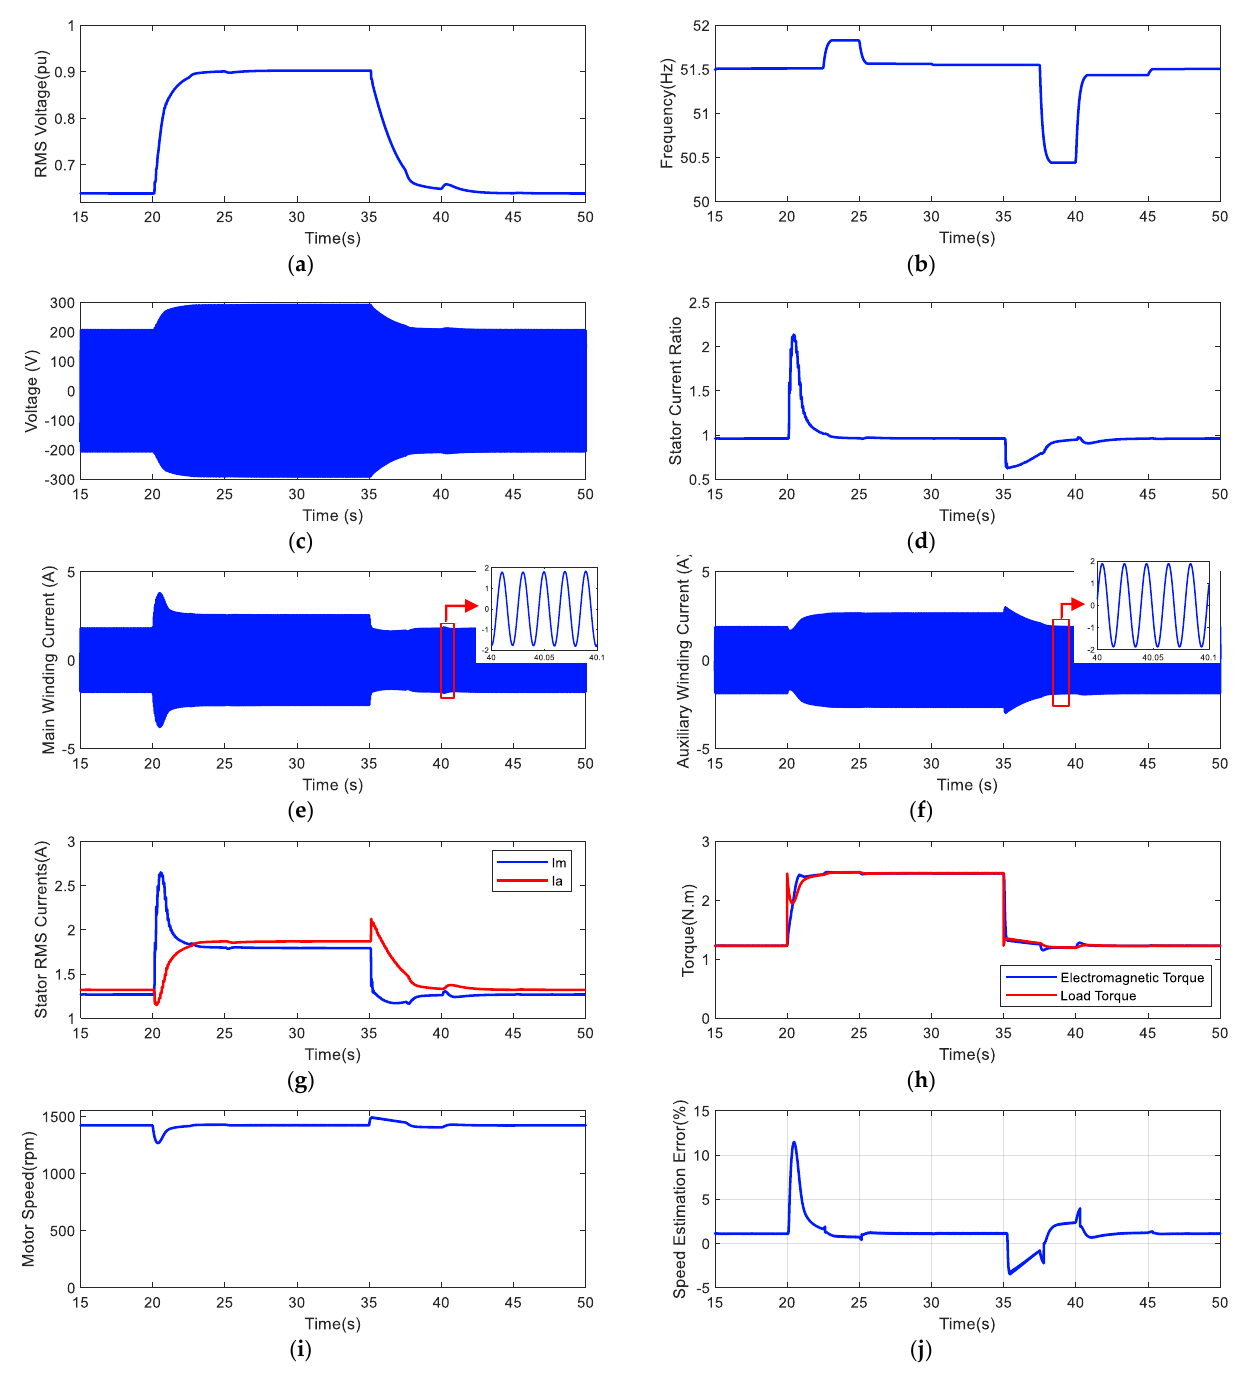
Figure 8. Simulation results with step change in load torque. ( a ) rms voltage, ( b ) frequency, ( c ) voltage waveform, ( d ) stator current ratio, ( e – g ) stator main and auxiliary winding currents, ( h ) motor and load torque, ( i ) motor speed and ( j ) speed estimation error.